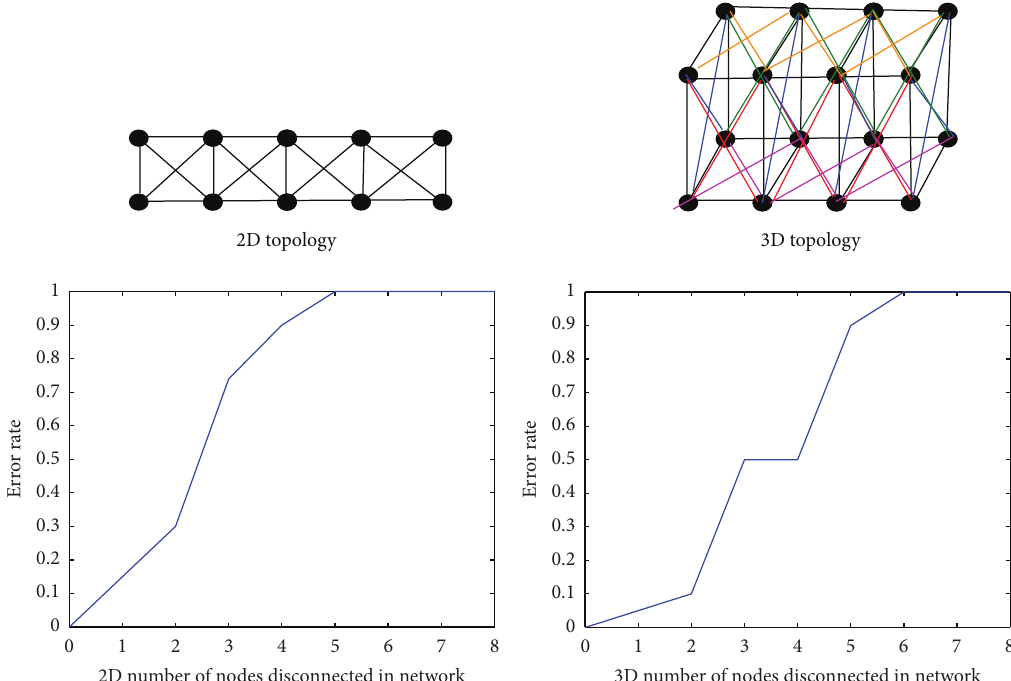
Figure 8: The relationship between random destruction number of node and connectivity.